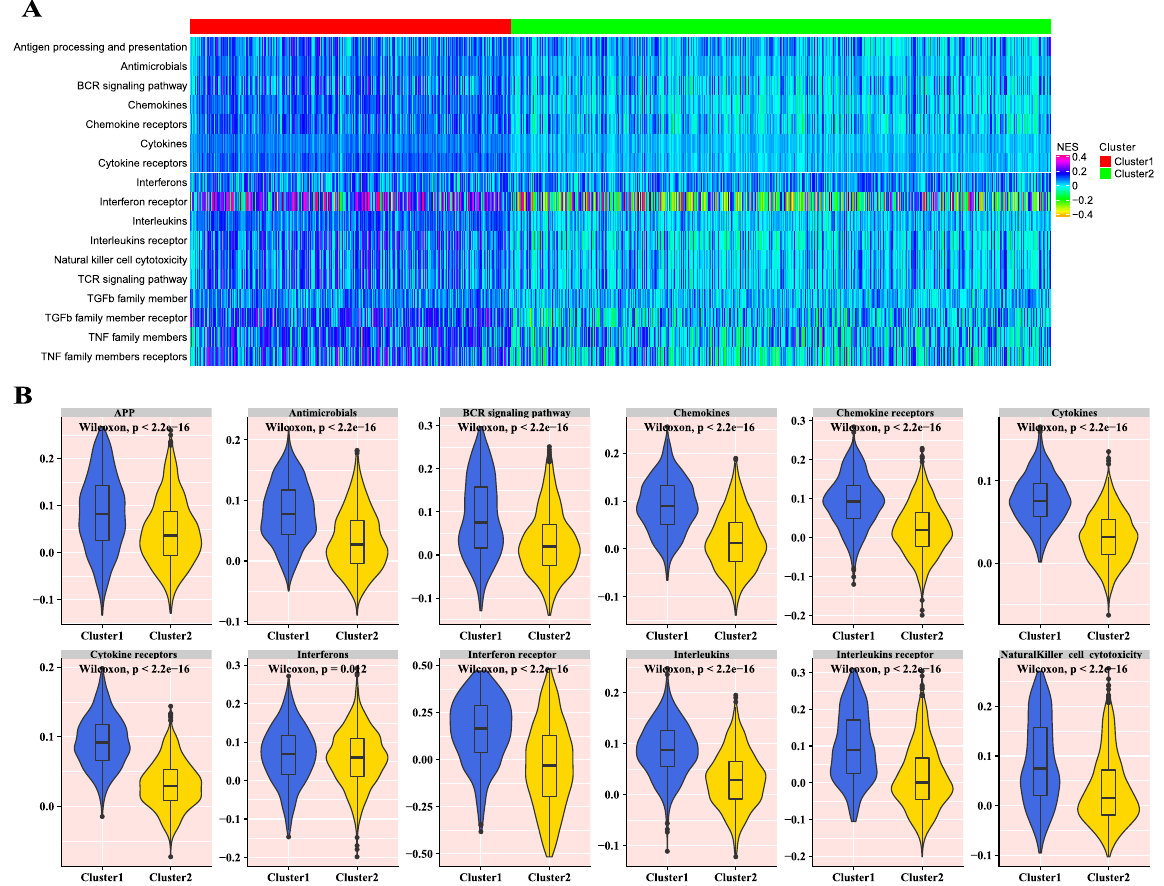
Figure 3. The immune infiltrate profile of two clusters. ( A ) The heatmap of the ssGSEA scores for 17 immune cell types in cluster 1 and cluster 2. (B) The violin plots of the tumor infiltrating levels in 12 immune cell types for in cluster 1 and cluster 2. APP: antigen processing and